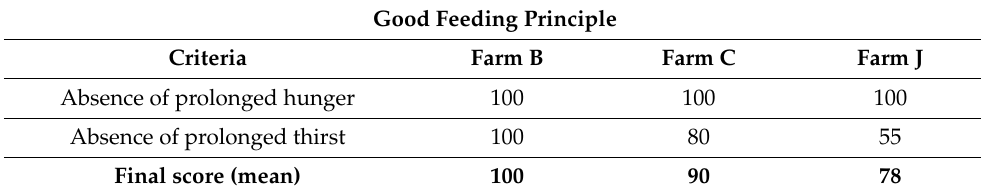
Table 11. Classification of the good feeding principle.